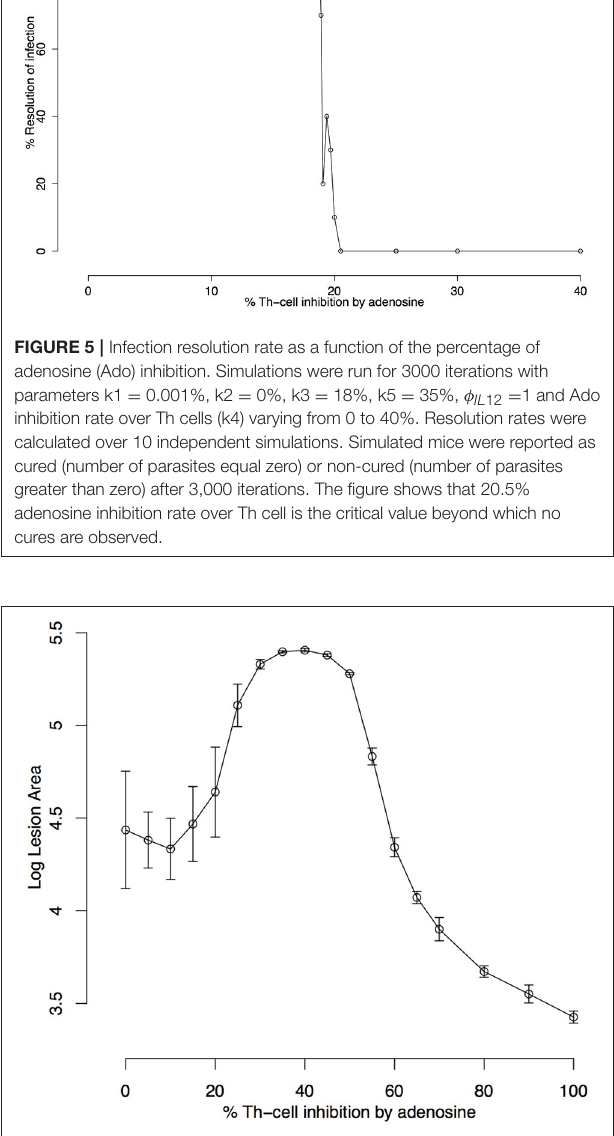
half-life, and conversely k 5 cannot be below 20%; a minimum of 30% was used for biological fidelity